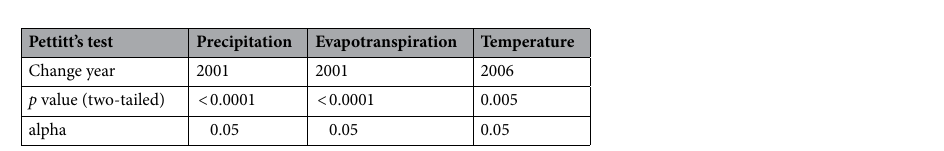
Table 3. Pettitt’s test of the annual precipitation, evapotranspiration, and average temperature.